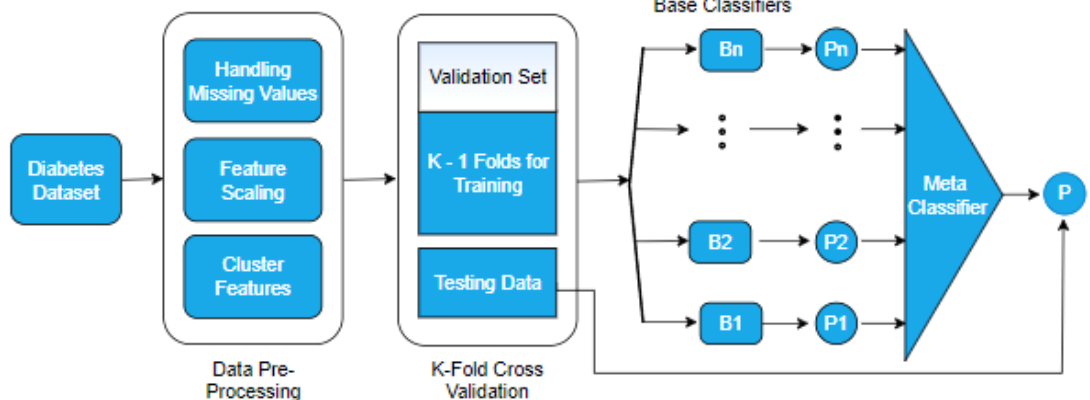
Figure 2. The architecture of the proposed stacked generation